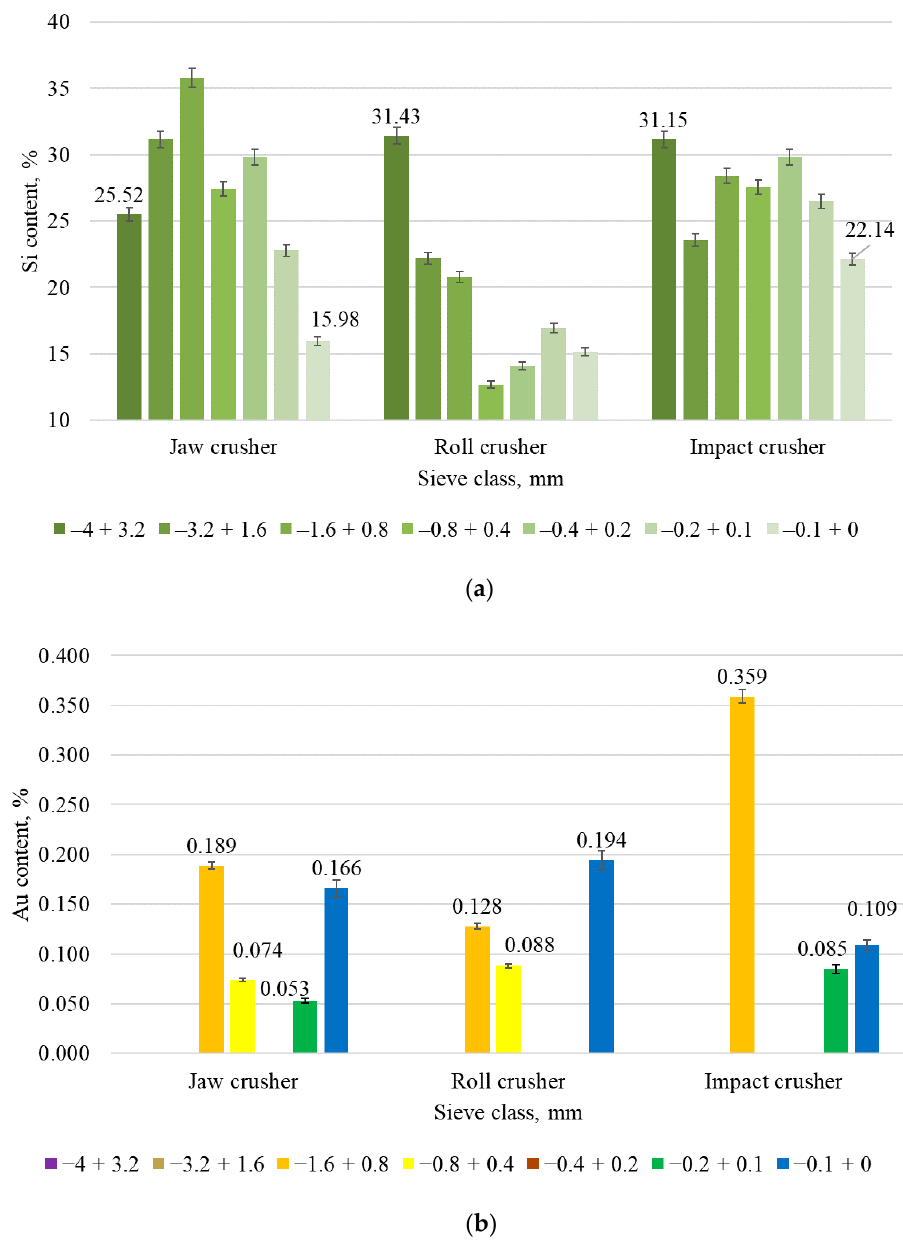
Figure 7. Silica ( a ) and gold (b ) content in the sieve classes of BDO sample after crushing in jaw, roll and impact crushers. Emerging “T” signs from bars show that the measurment was provided three times and such standard deviations from the values are obtained.